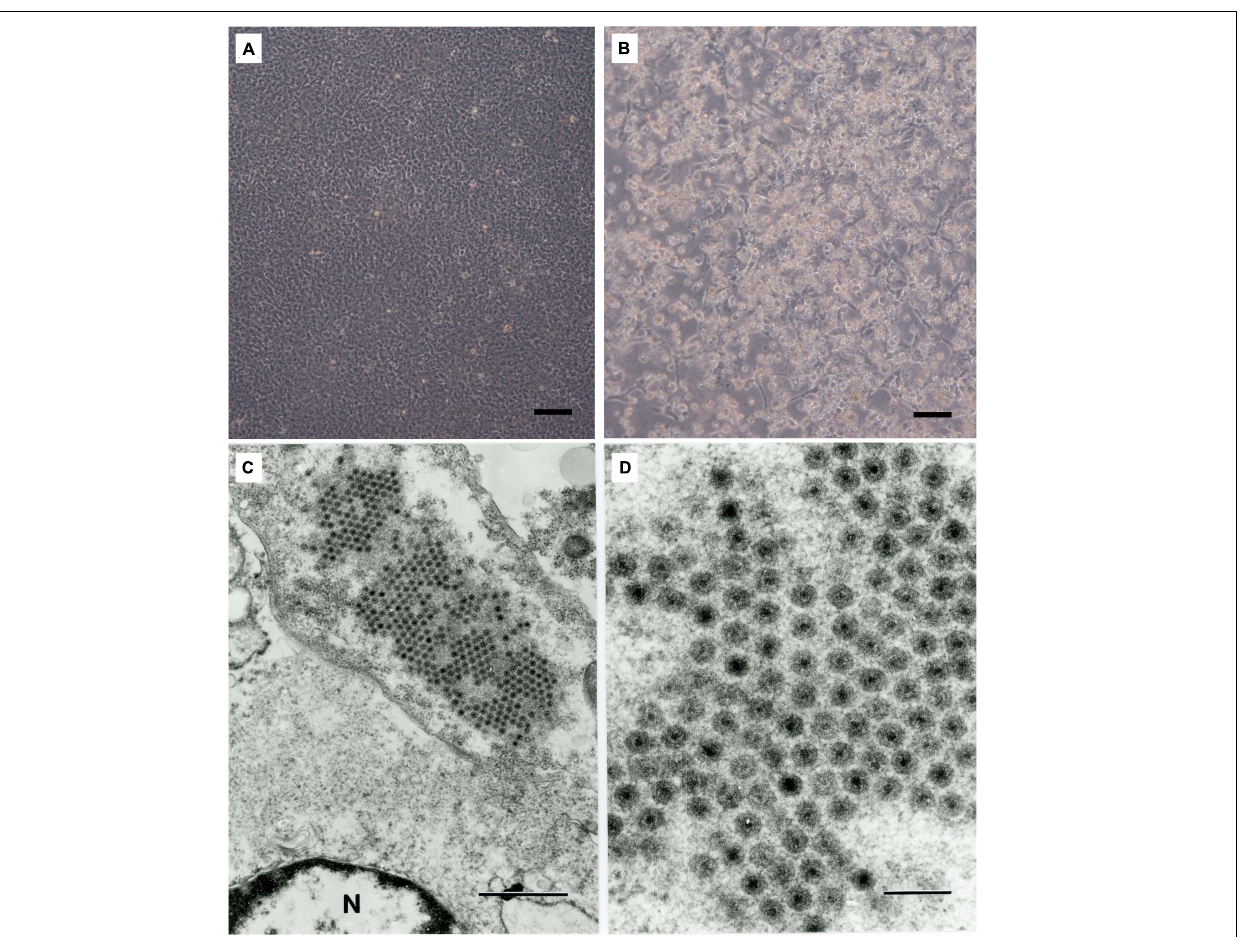
FIGURE 2 | Cell culture (A,B) and transmission electron micrographs (C,D) of phocid orthoreovirus 1 (PhRV1) infecting Vero.DogSLAMtag cells. (A) Uninfected Vero.DogSLAMtag cells. Scale bar = 100 µ m. (B) Passage two PhRV1 (WDFW2008-12 brain isolate) 11 DPI showing rounding up of infected cells with detachment of cells and the early stages of the disintigration of the cell monolayer. Scale bar = 100 µ m. (C) Intracytoplasmic virus inclusion. N-fragment of cell nucleus with depleted chromatin in the nucleoplasm and chromatin condensation at the periphery of the nucleus. Bar = 1 µ m. (D) Fragment of virus inclusion with particles ∼ 75 nm in diameter in different stages of maturation. Bar = 200